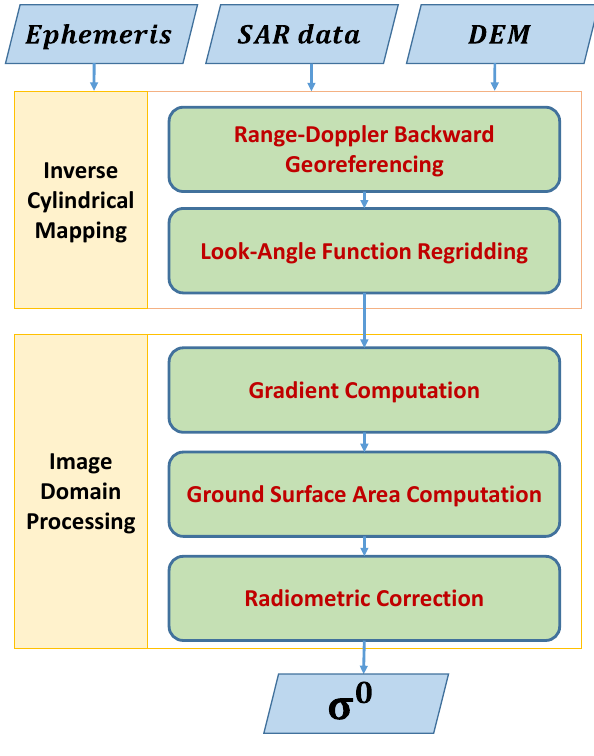
Figure 6. Processing Scheme.